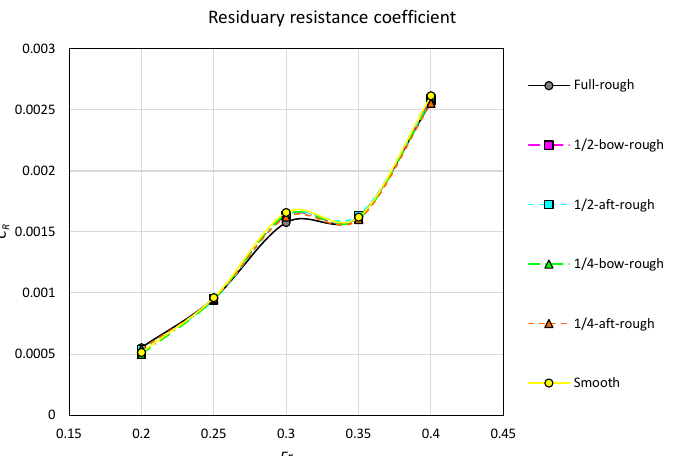
Figure 10. C F of the Wigley hull with different hull conditions predicted from the current Figure 10. 𝐶 (cid:3007) of the Wigley hull with different hull conditions predicted from the current CFD CFD simulations. simulations.